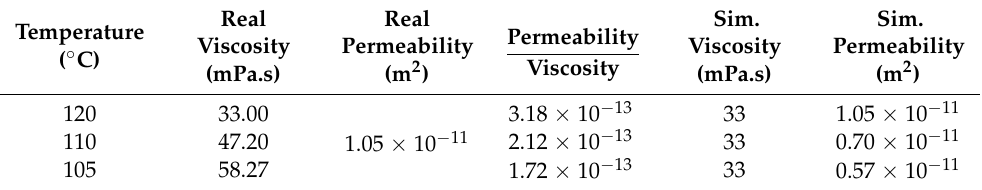
Table 4. Temperature-dependent real and simulation values for viscosity and permeability. Figure 12. Permeability values contour. Real Viscosity Temperature (°C) (mPa.s)